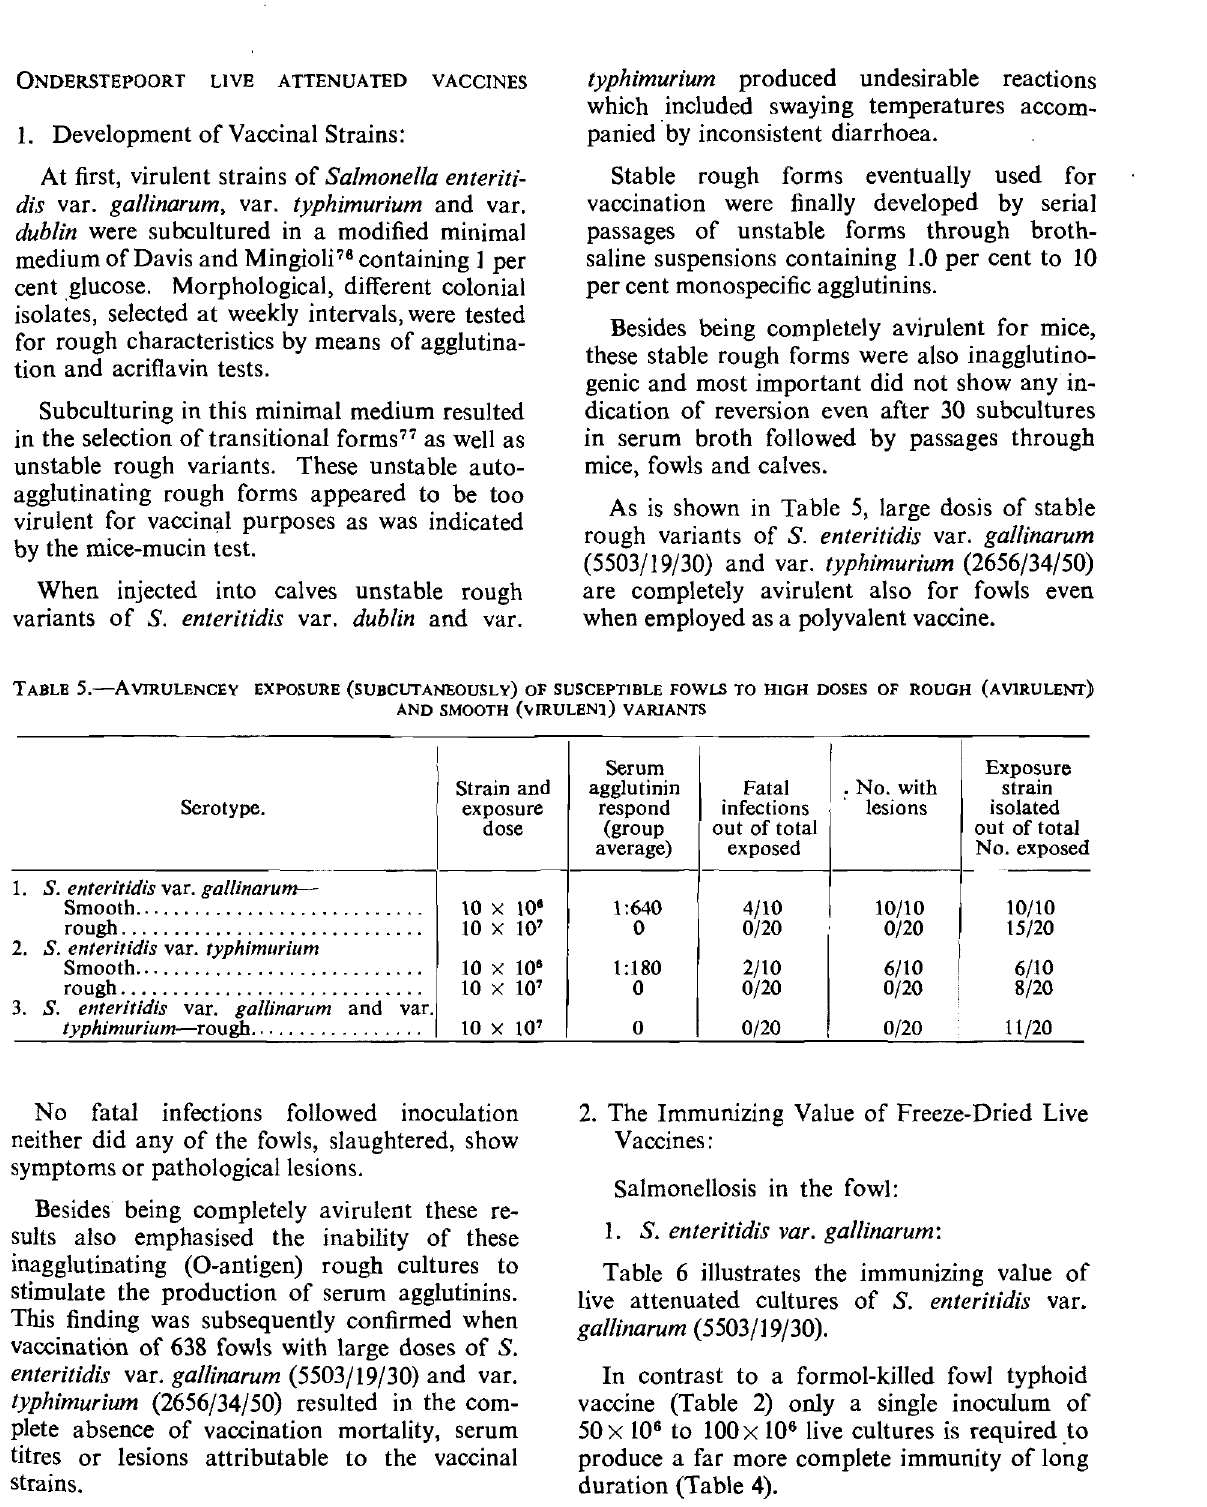
1. S. enteritidis var.